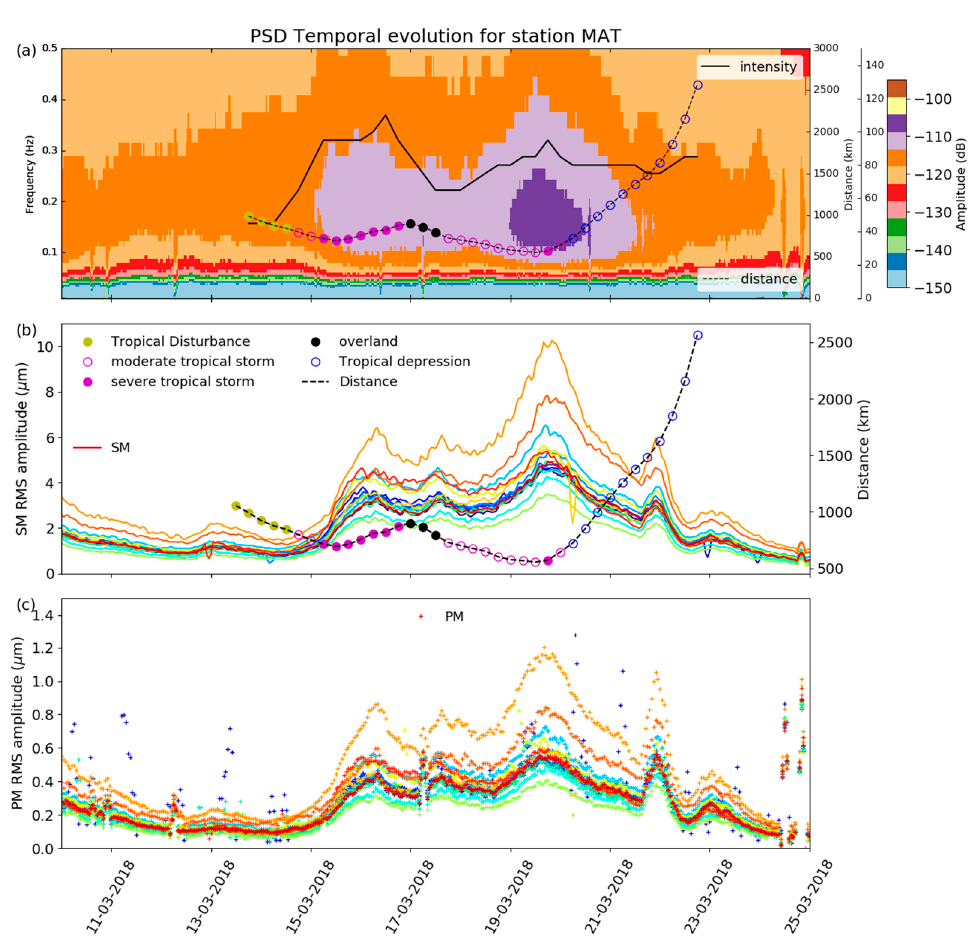
Figure 7. Temporal variation of the microseismic noise recorded during TS ELIAKIM. ( a ) Spectrogram at seismic station MAT (see location in Figure 6b) between 10 and 25 March and up to 0.5 Hz, together with the storm intensity (continuous black line) and distance between the storm center and the seismic station (dashed black line). The colored circles indicate the intensity of the storm every 6 h, as on Figure 6a). ( b ) Secondary microseisms RMS amplitude variations measured at the island seismic stations (left axis, in micrometers), together with the distance between the storm and seismic station (right axis, in km). ( c ) PM RMS amplitude variations (left axis) at Réunion Island seismic stations.